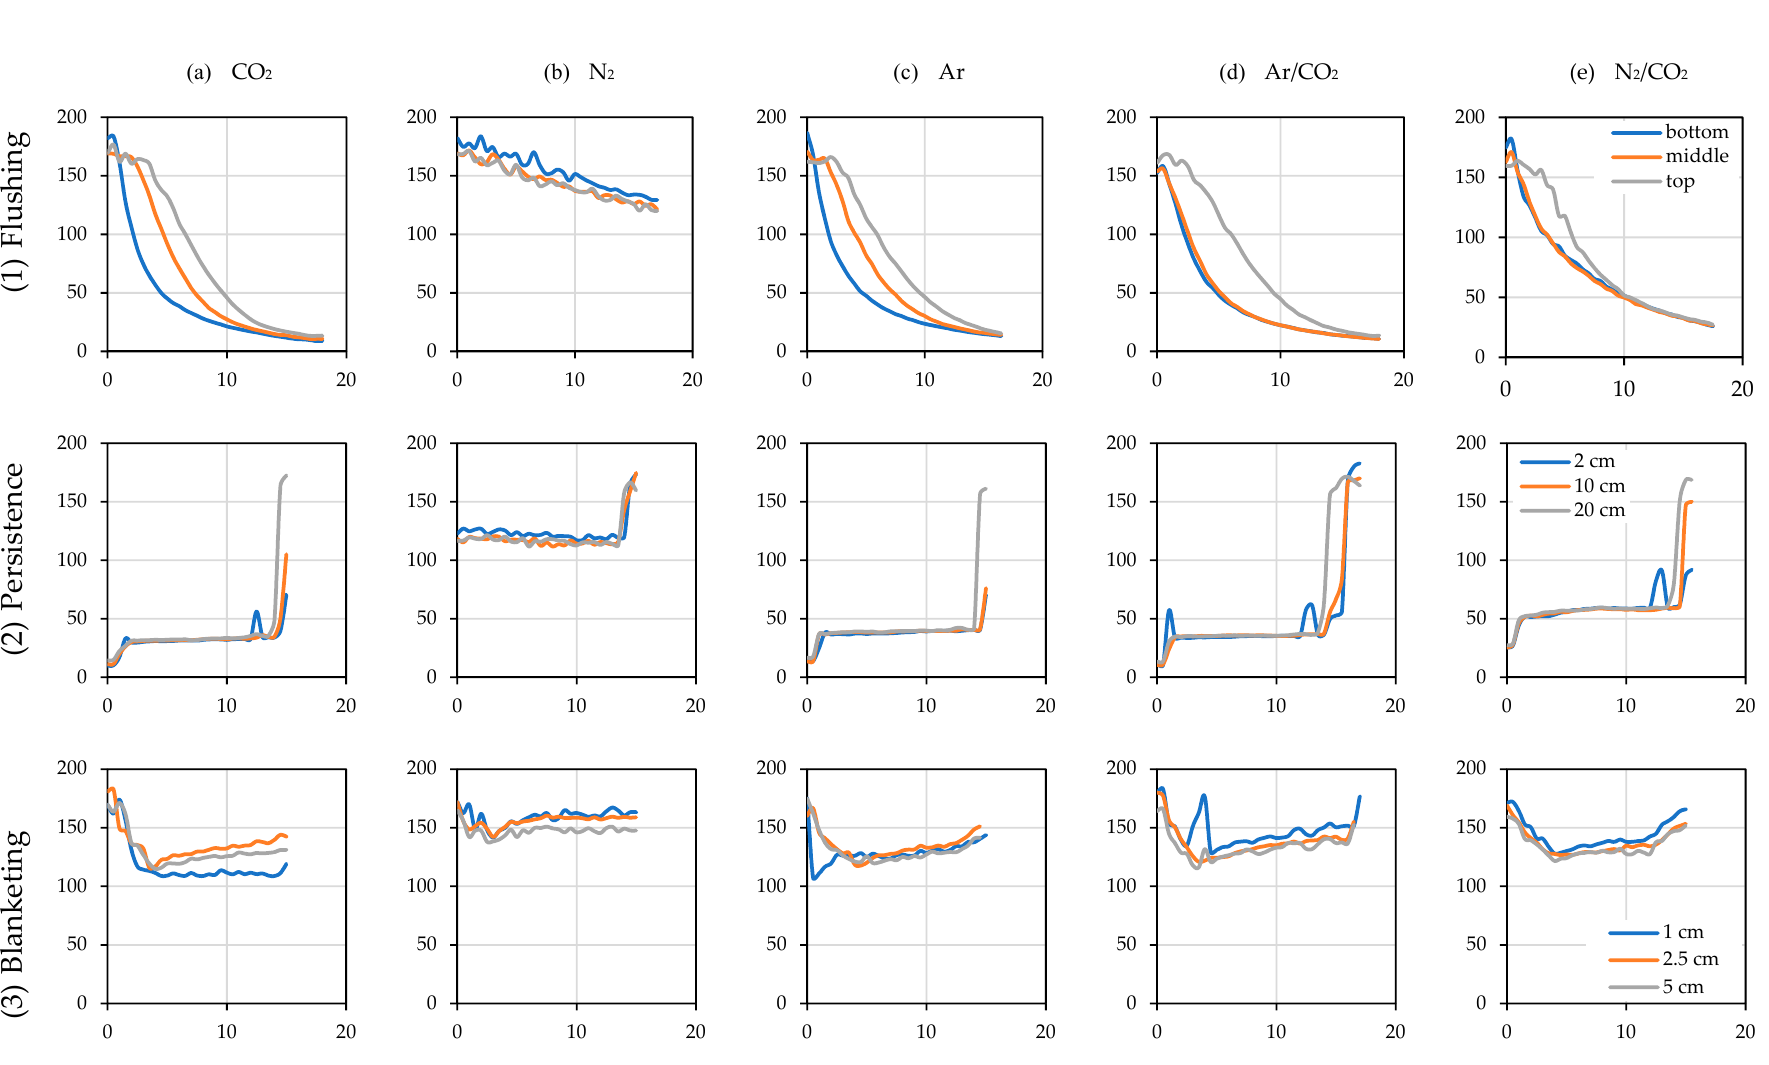
Figure 7. Evolution of the oxygen partial pressure (hPa, Y axis) with time (min, X axis) in the empty tanks that were filled ( 1 ) and ( 2 ) and in the full one that was emptied ( 3 ).